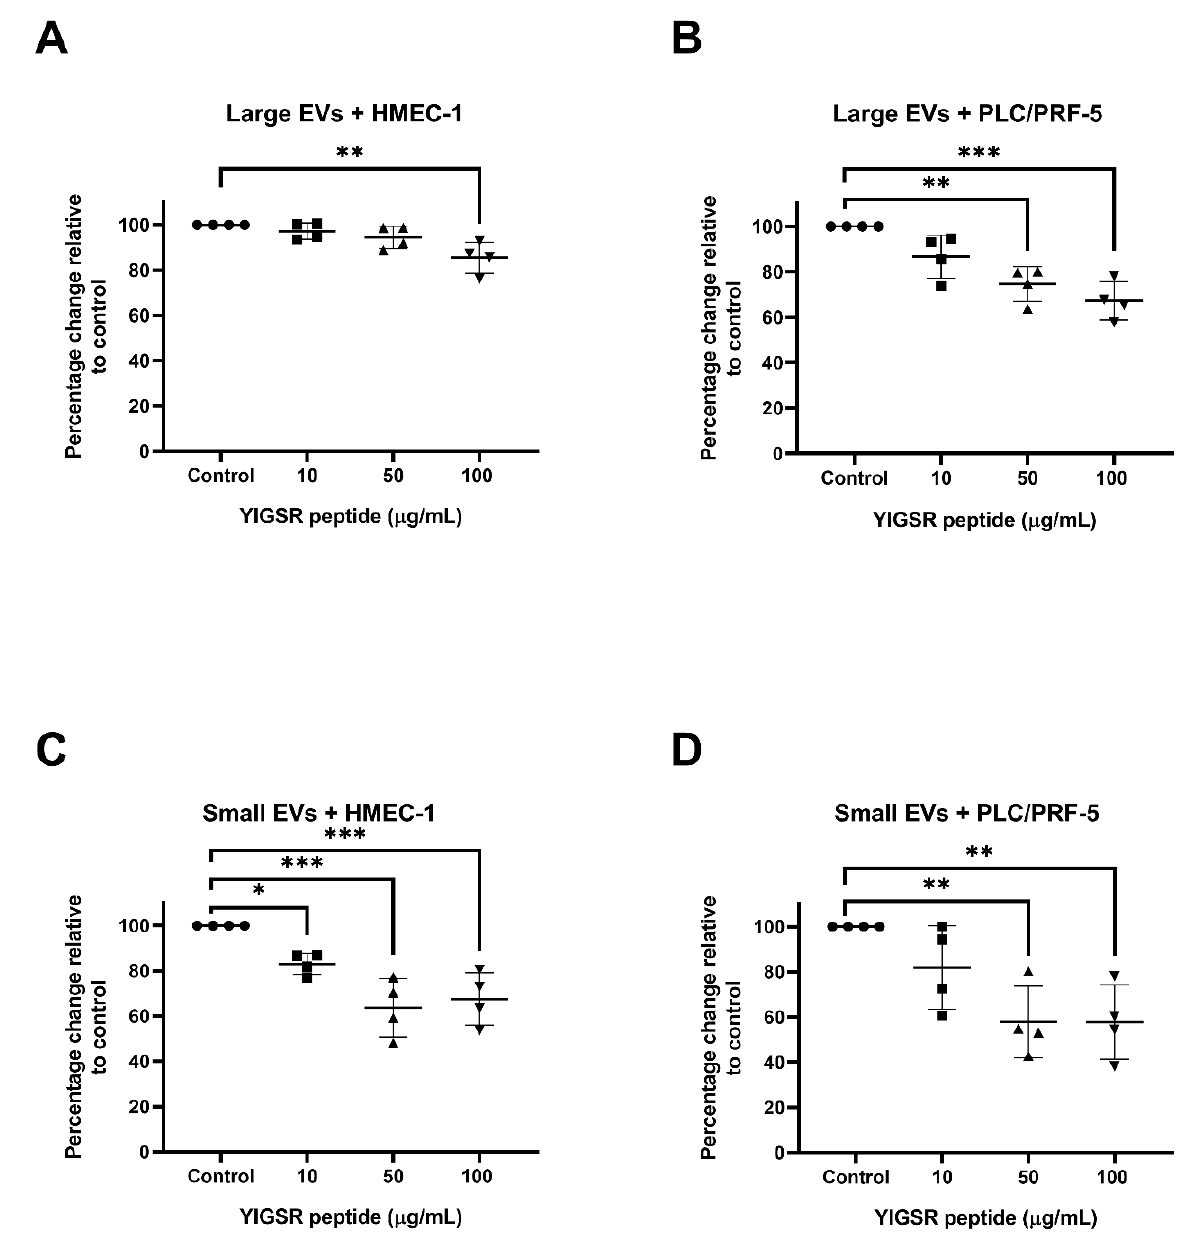
Figure 4. YIGSR peptide reduced the interaction of the placental EVs with the endothelial and liver cells. Fluorescently labelled placental large or small EVs were incubated with increasing concentrations of the YIGSR peptide ( n = 4), and the interaction with the HMEC-1 or PLC/PRF-5 cells was quantified using a BioTek Synergy 2 microplate reader (Agilent, CA, USA). The interaction of the placental ( A ) large or ( C ) small EVs with the HEMC-1 cells was significantly reduced by the YIGSR peptide pre-treatment at the concentration of 100 µ g/mL and 10 µ g/mL, respectively. The interaction of the placental ( B ) large or ( D ) small EVs with the PLC/PRF-5 cells was significantly reduced by the YIGSR peptide pre-treatment at the concentration of 50 µ g/mL compared to no YIGSR peptide pre-treatment. Values were normalized to the untreated HMEC-1 or PLC/PRF-5 cells. Data are shown as mean ± SEM. Differences among the groups were tested with a RM one-way ANOVA with multiple comparisons (* p < 0.05, ** p < 0.01, *** p <